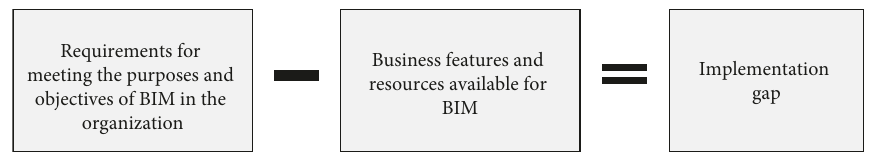
Figure 6: Determining the “implementation